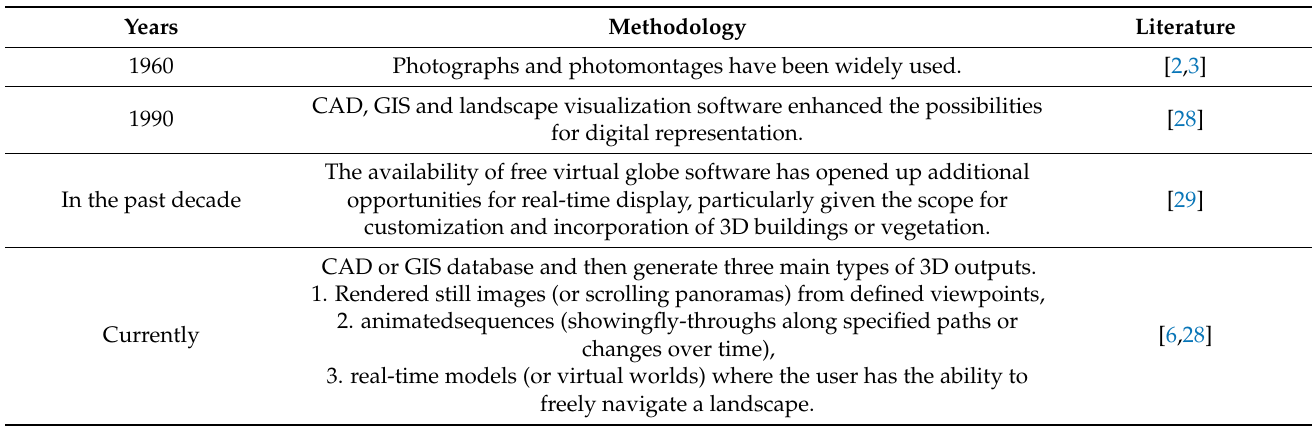
Table 1. Development of visualisation in the